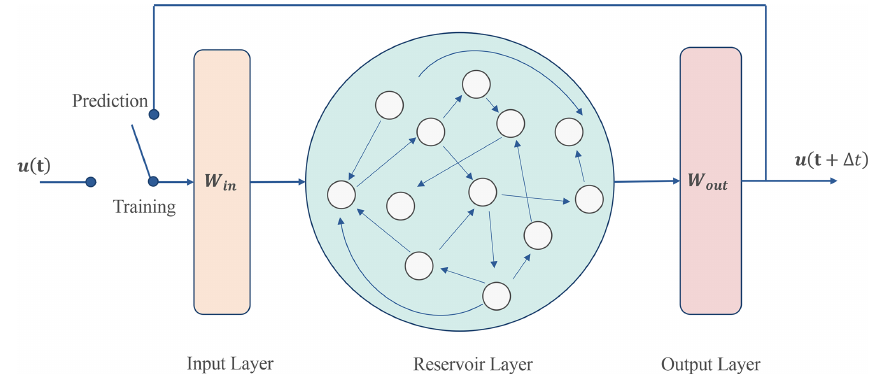
Figure 1. The conceptual diagram of reservoir computing architecture. The network consists of an input layer, a hidden layer called reservoir, and an output